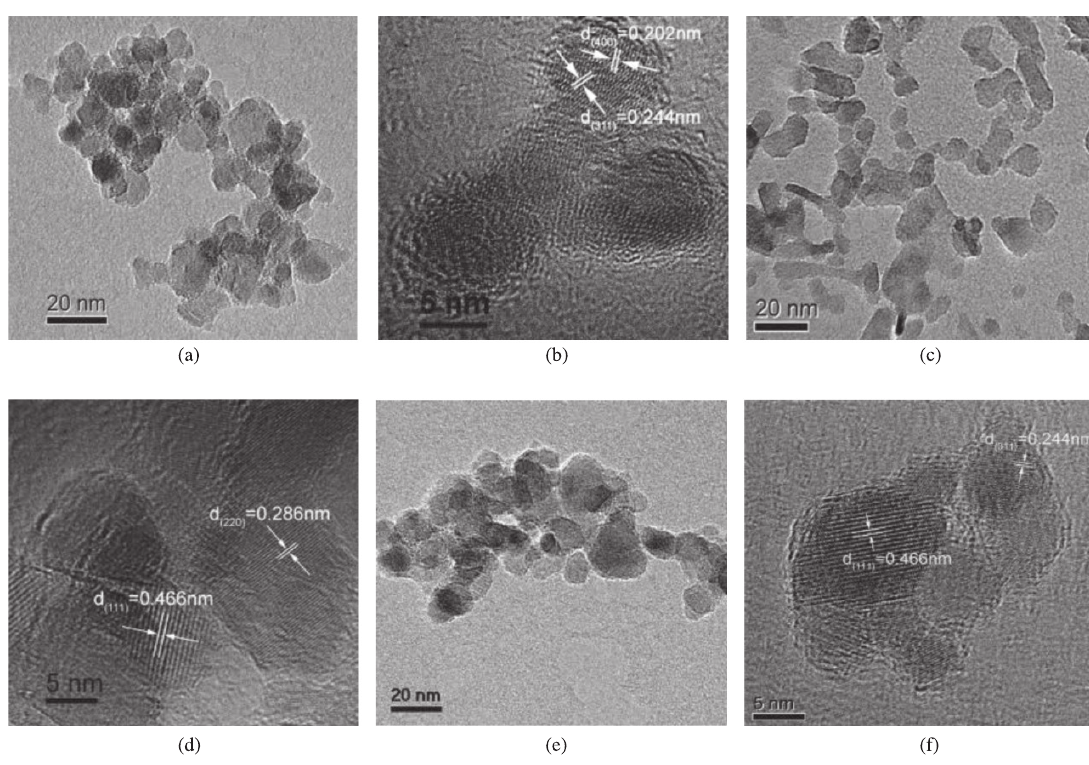
Figure 5. HR-TEM images of MgAl O nanoparticles calcined at 900 °C for 2h (a,c,e.morphology image of nanoparticles, which synthesized 2 4 conditions of SPAN-80 + Triton X-100, forward-titration, and SPAN-80 + Triton X-100, reverse-titration, and NP-40, forward-titration, respectively; b, d, f. lattice fringe image of nanoparticles from a, c, e,